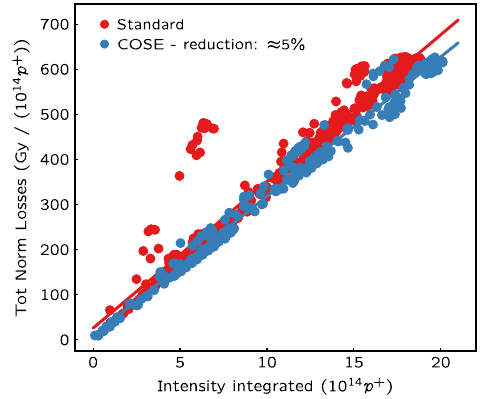
FIG. 12. Comparison of total normalized losses in LSS2 per 15 minutes as a function of intensity for tune sweep and COSE. The origin of the phenomenon of higher normalized losses for higher total intensity extracted per time unit is still under investigation. It is however present for both methods of slow extraction with a slightly reduced slope for